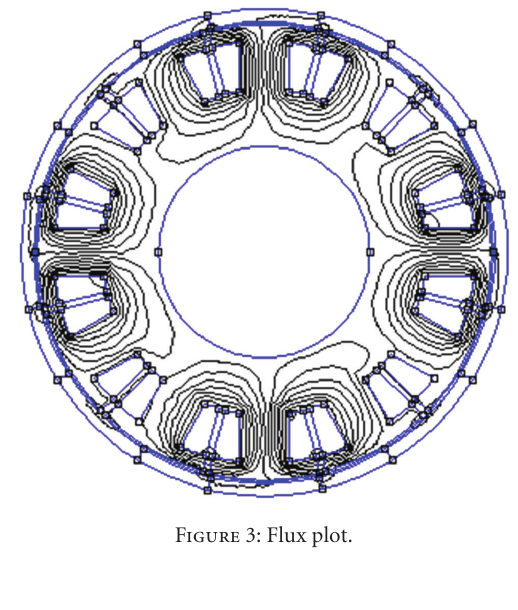
Table 2: Material properties.